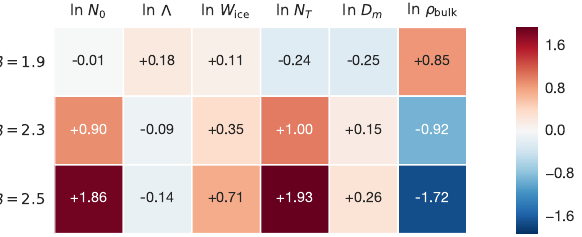
Figure 7. The root-mean-square changes in the microphysical pa- rameters in response to changes in the mass–dimensional exponent β . The standard assumption of this paper, β = 2 . 1, is used as the baseline. The value of β is indicated on the left side of each row. The analysis is based on the 4 December 2015 case (Sect.